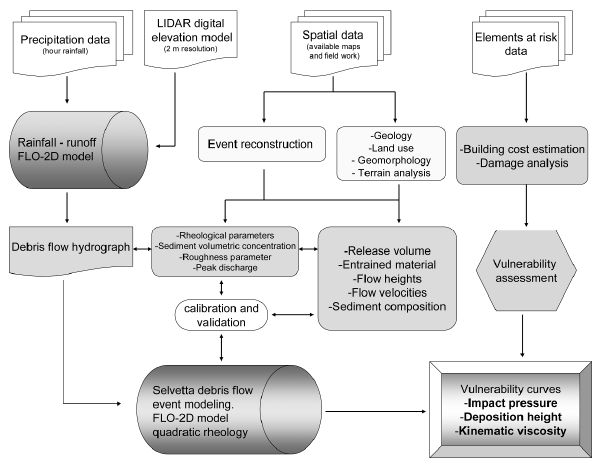
Fig. 5. Flowchart of the methodology applied in the Selvetta case study